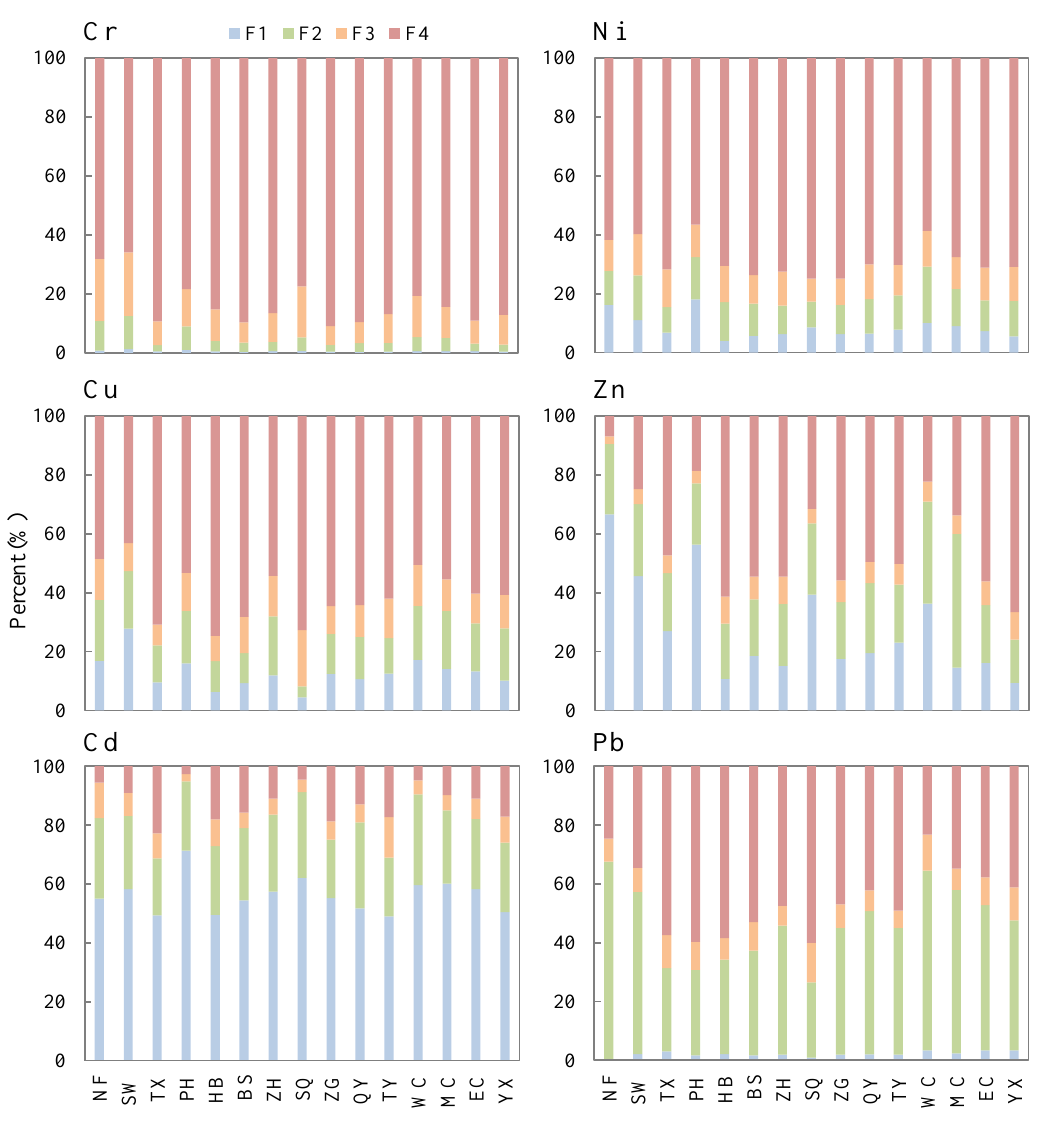
Figure 5. Percentages of Cr, Ni, Cu, Zn, Cd, and Pb existing as different fractions of the BCR sequential extraction procedure for sediments sampled at 15 sites. F1, exchangeable and carbonate included fraction; F2, reducible fraction; F3, oxidizable fraction; and F4, residual